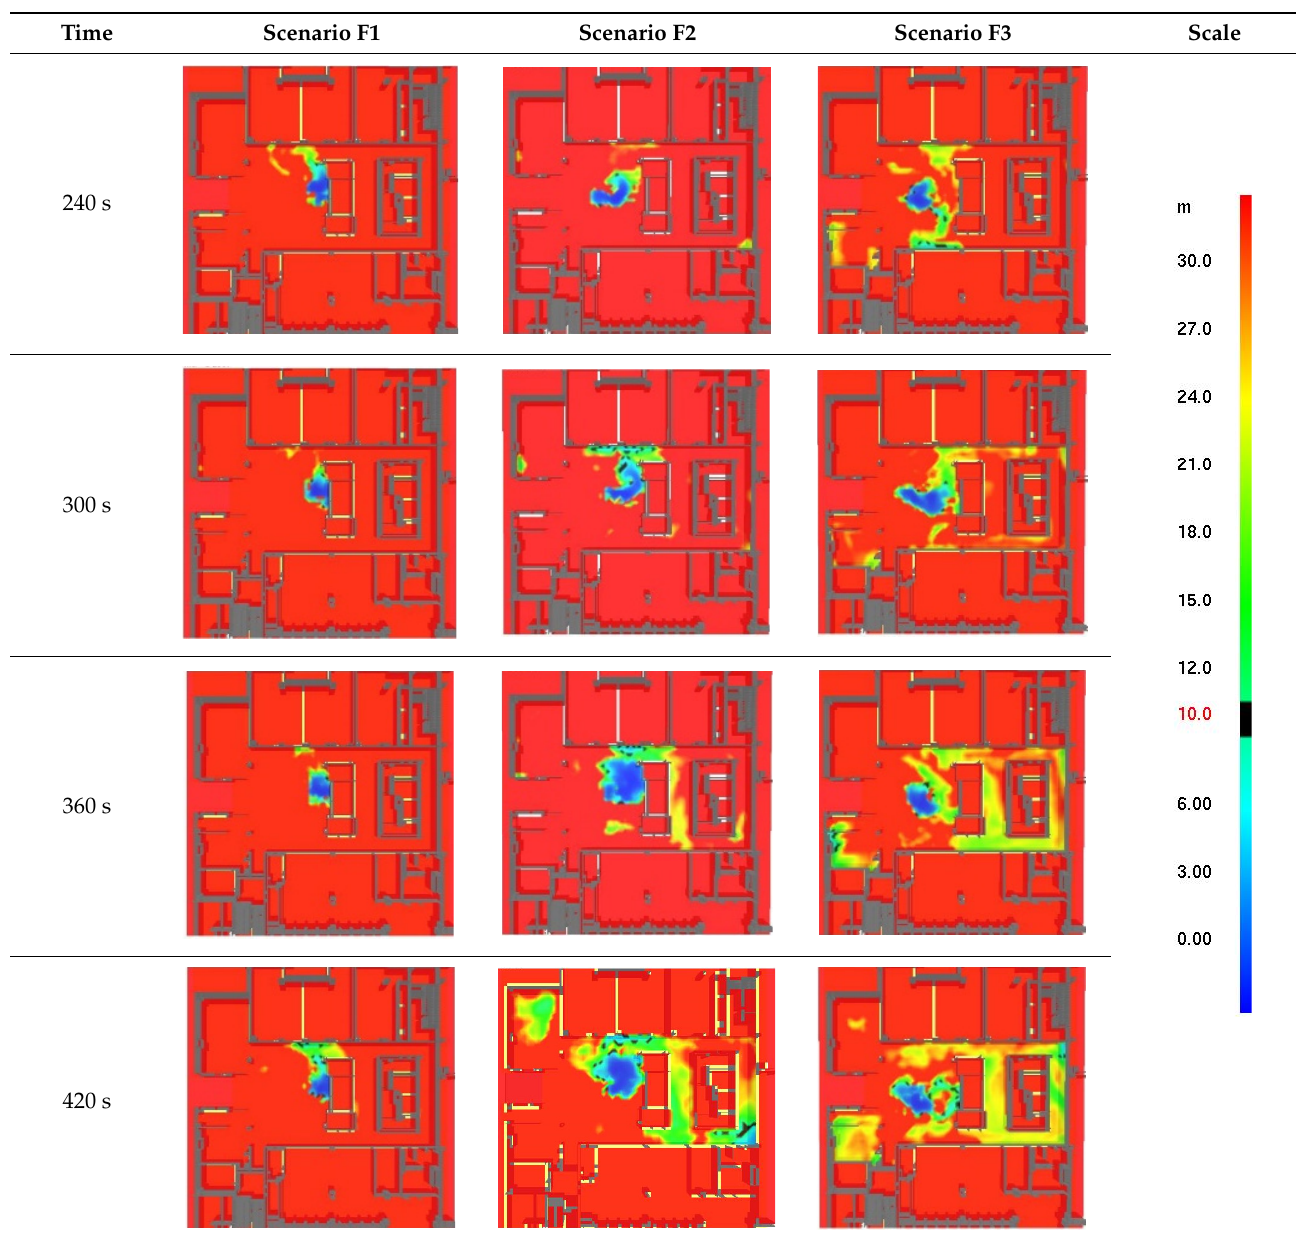
Table 4. Visibility at the level of 1.8 m from the ground floor.